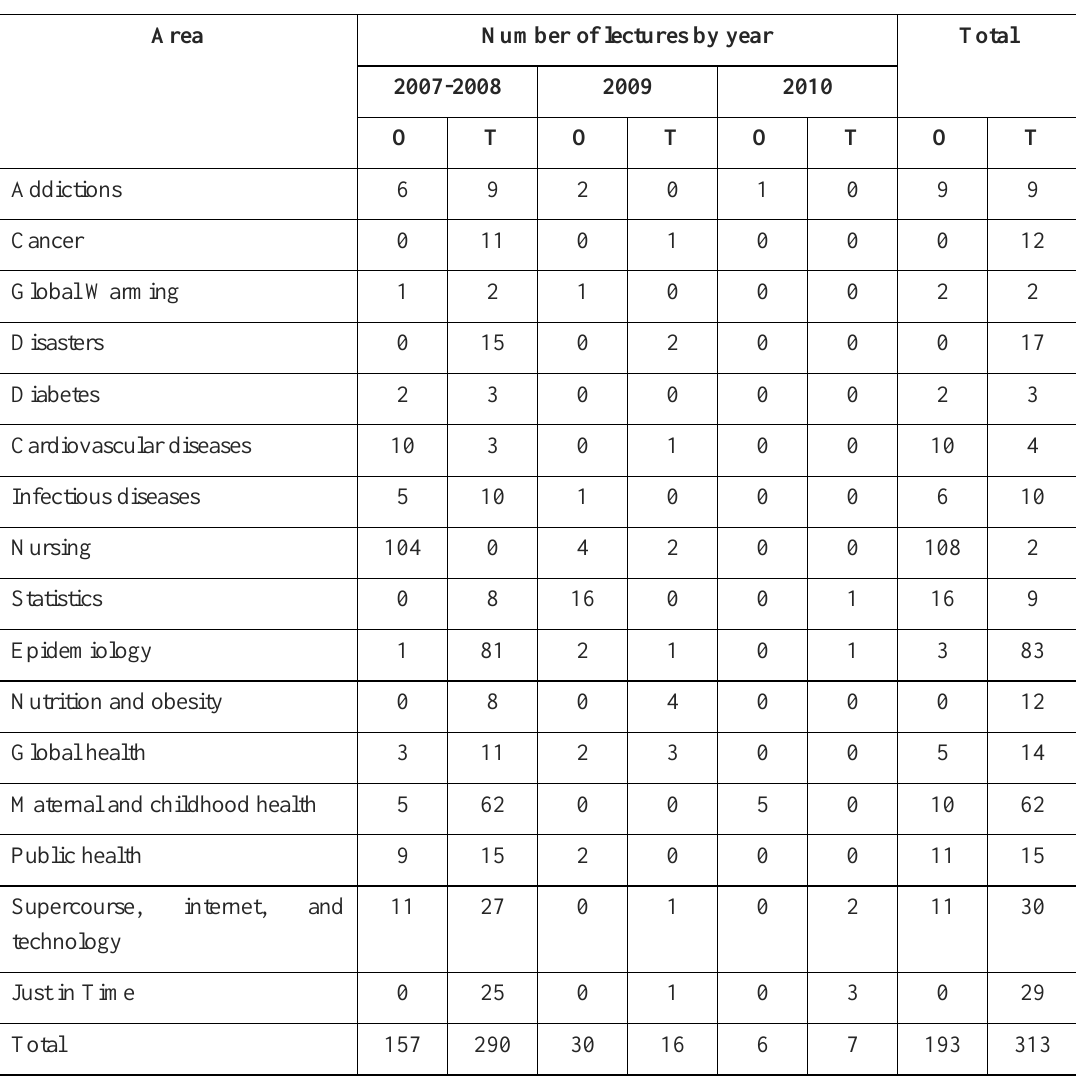
Table III: Areas of concentration for Latin American Supercourse and numbers of lectures available in these